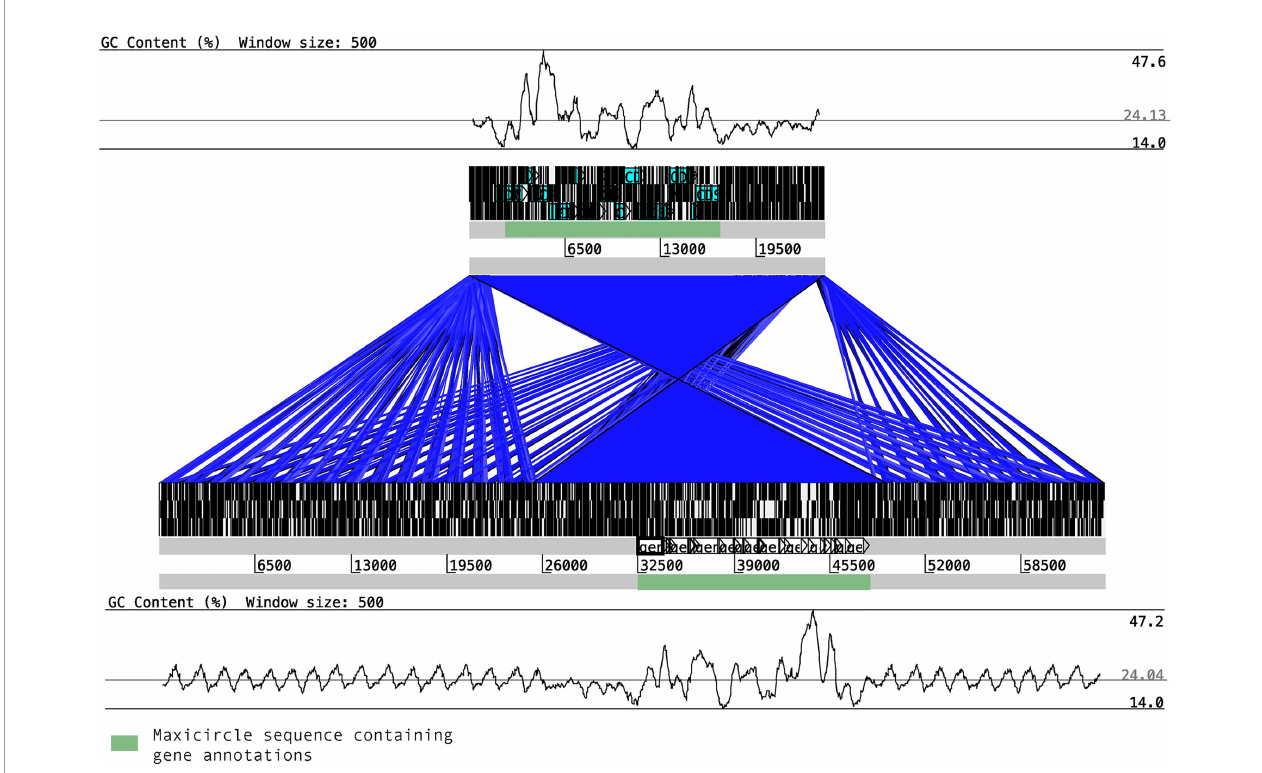
FIGURE 1 | Synteny blocks between T. cruzi maxicircles. The maxicircle sequence of Y (upper block) and Bug2148 (low block) are composed of two main regions, the coding region (shown in green boxes) and the variable region, which is mainly composed of short repetitions. The %GC content for each strain shows clear differences between the two main